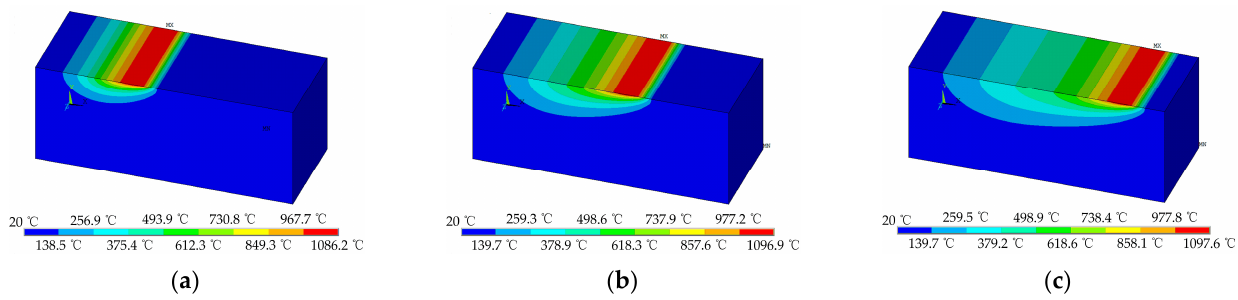
Figure 3. Grinding temperature distribution at different times ( a e = 350 μ m, v w = 9 m/min, v s = 26.4 m/s): ( a ) 0.15 s; ( b ) 0.3 s; and ( c ) 0.45 s.